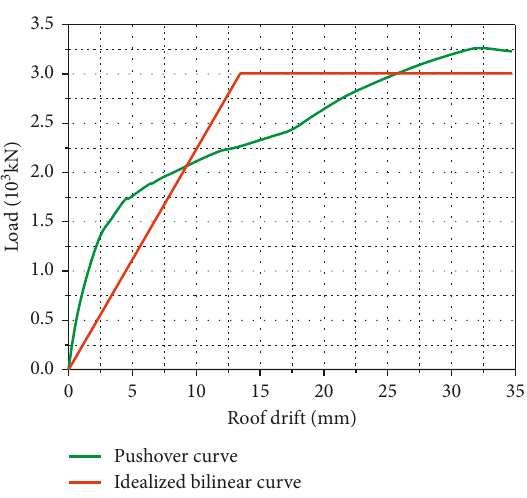
Figure 31: Pushover curve.